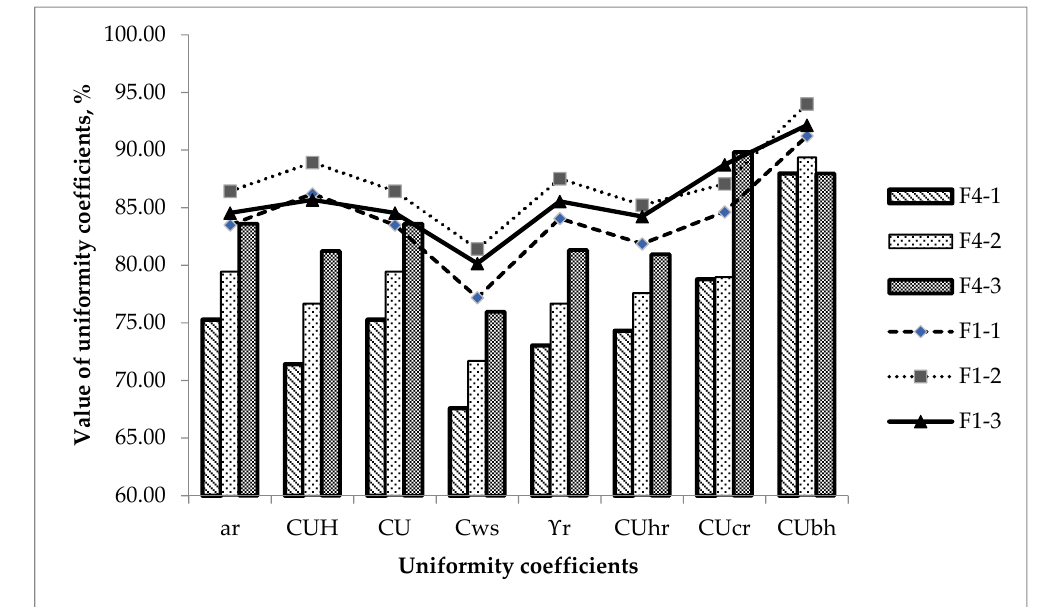
Figure 8. The results of different coefficients of uniformity for all experimental fields, all for F1 and F4 where: ar—coefficient of uniformity according to Oehler, CUH—coefficient of uniformity according to Heerman and Hein, CU—coefficient of uniformity according to Christiansen, Cws—coefficient of uniformity according to Wilcox and Swailes, γ r—coefficient of uniformity according to Voigt, CUhr—coefficient of uniformity according to Hart and Raynolds, CUcr—coefficient of uniformity according to Criddle et al.